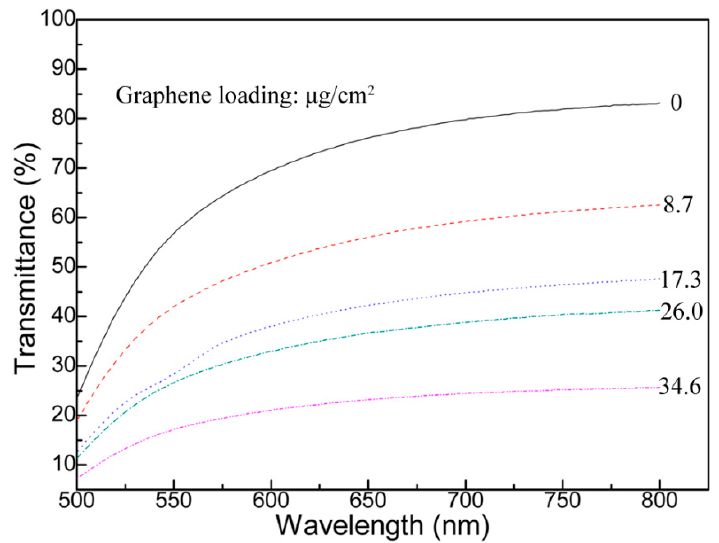
Figure 6. Transmittance spectra of coated Kapton with different graphene loadings. Figure 5. ( a ) Raman spectra of graphene on filtered membrane and graphene on Kapton; ( b ) AFM of graphene coating on Kapton.